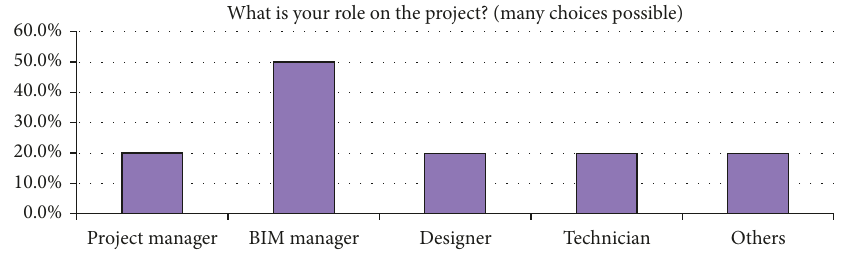
Figure 2: Roles of the respondents to the